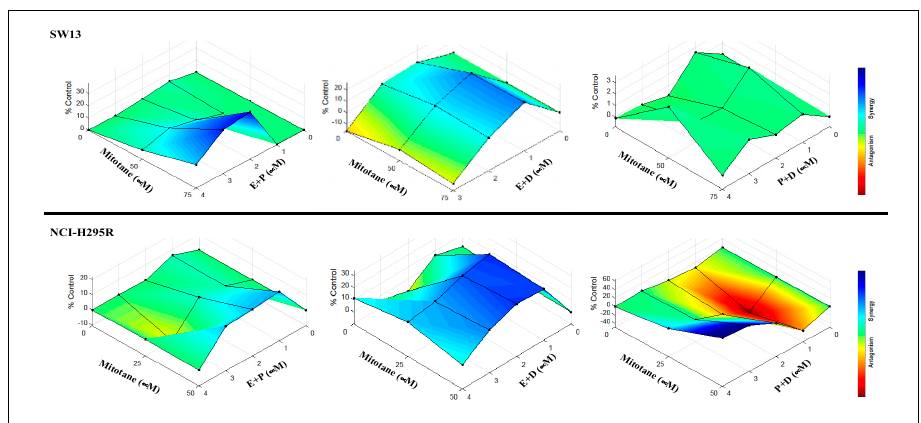
Figure 5. Comparison of viability of chemotherapeutic drug combinations (M + P + E or M + P + D or M + E + D) and Italian protocol (E + D + P + M) in NCI-H295R and SW13 cells.